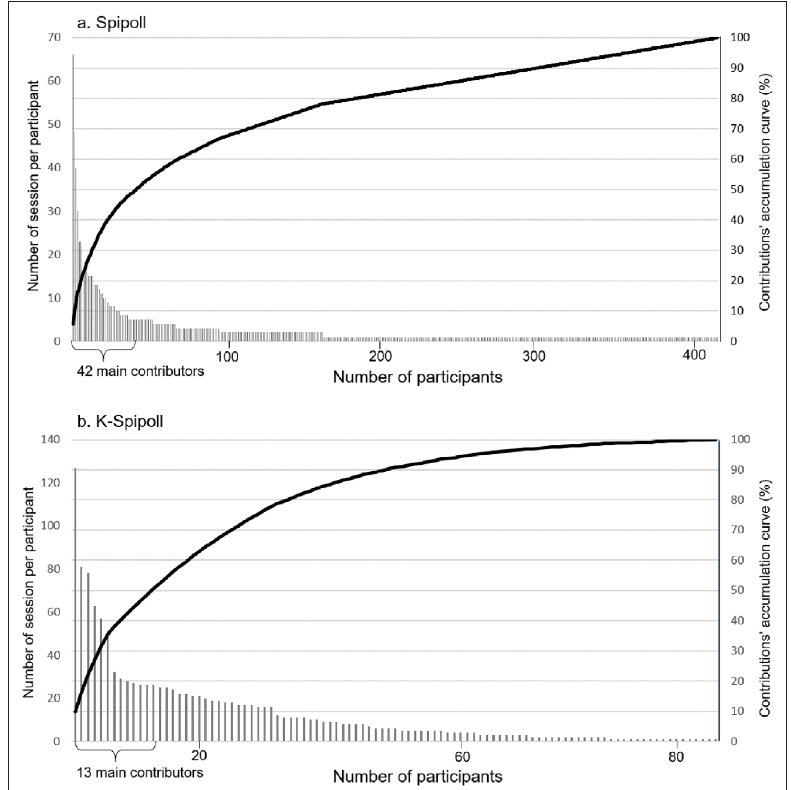
Figure 5: Number of sessions per participant (histogram) and contribution to the dataset (accumulation curve) of the Spipoll (a) and the K-Spipoll (b)